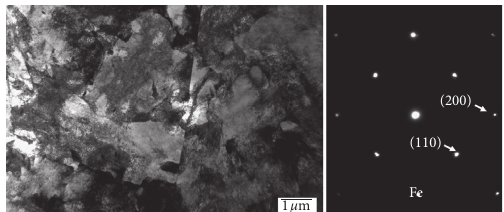
Figure 5: Microstructures of the as-cladded 2.25Cr1Mo0.25V sample made by